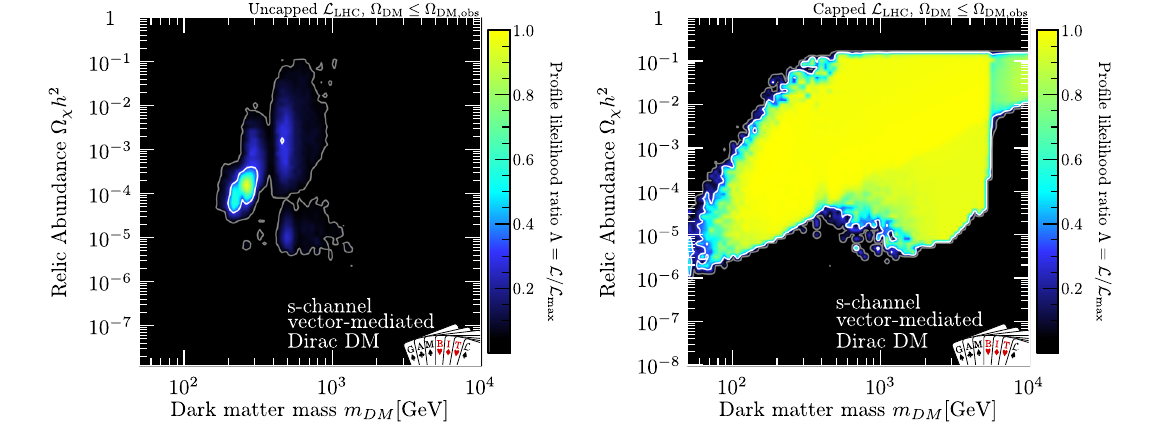
Fig. 6 Profile likelihood as a function of relic density of the Dirac fermion DM model, allowing the model to underproduce the relic abun- dance. The capped collider result is shown on the right. We do not show